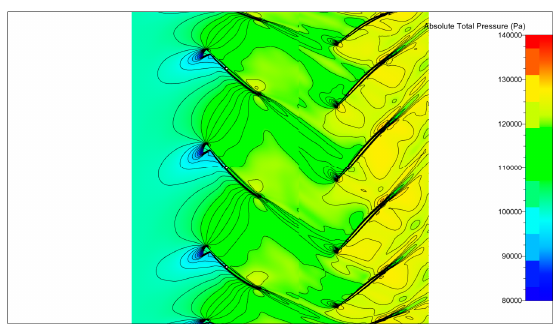
Figure 38. Unsteady Reynolds Averaged Navier–Stokes (URANS) calculations: instantaneous entropy field. Section 0.95 h. Operating point at (cid:1866)(cid:3364) = 100%.